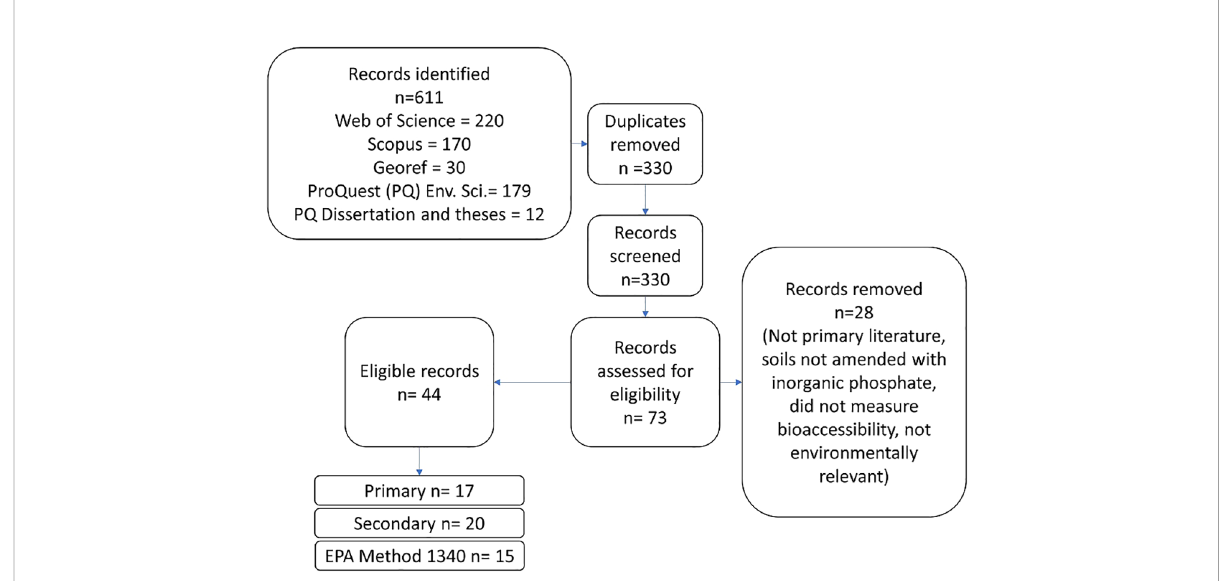
FIGURE 1 Flowchart of literature search and eligible records in this